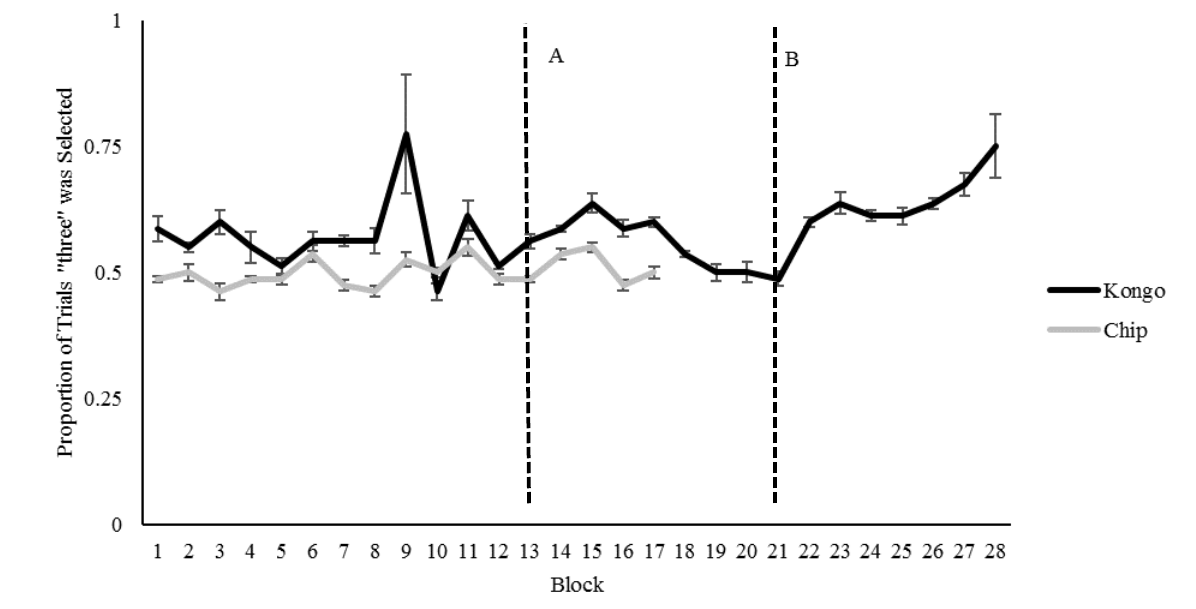
Figure 7 . Proportion of trials during the “one versus three” on which Kongo and Chip selected the “three” stimulus across blocks of four sessions- Line A indicates session at which“one incorrect versus three” phase began for Chip, Line B indicates session at which“one incorrect versus three” phase began for